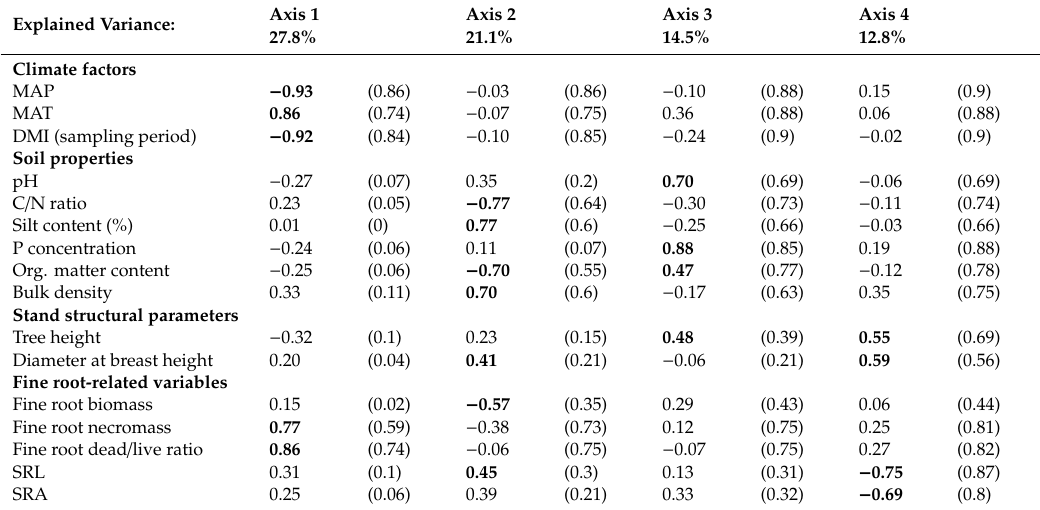
Table 4. Results of the principal components analysis for the spring inventory in 2017. Given are the loadings of the selected variables along the four axes with the highest explained variance in the dataset. Bold numbers mark the variables with the highest loading ( > 0.4) on the respective axis. The values in brackets give the cumulative fraction of variance explained by the variable. MAP = mean annual precipitation, MAT = mean annual temperature, DMI = de Martonne aridity index of the three months prior to